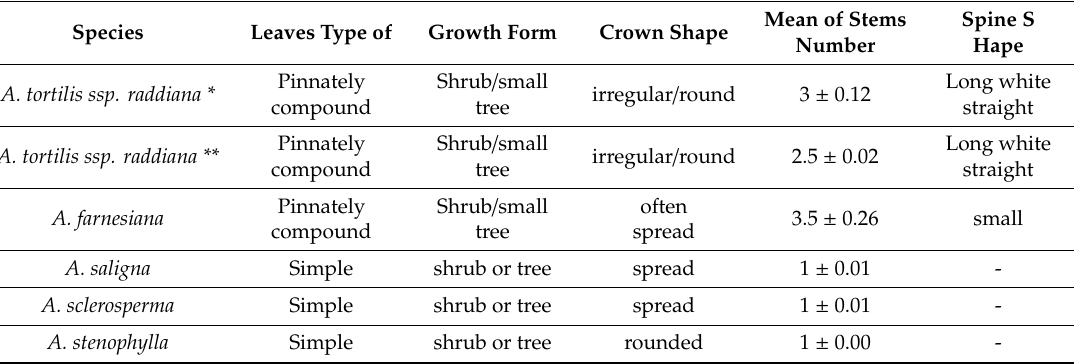
Table 2. Qualitative description of some Acasia species in